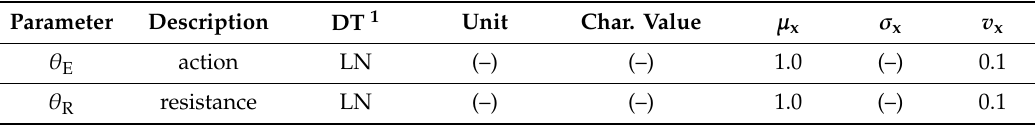
Table 4. Overview of the model uncertainty—statistical description of the variables